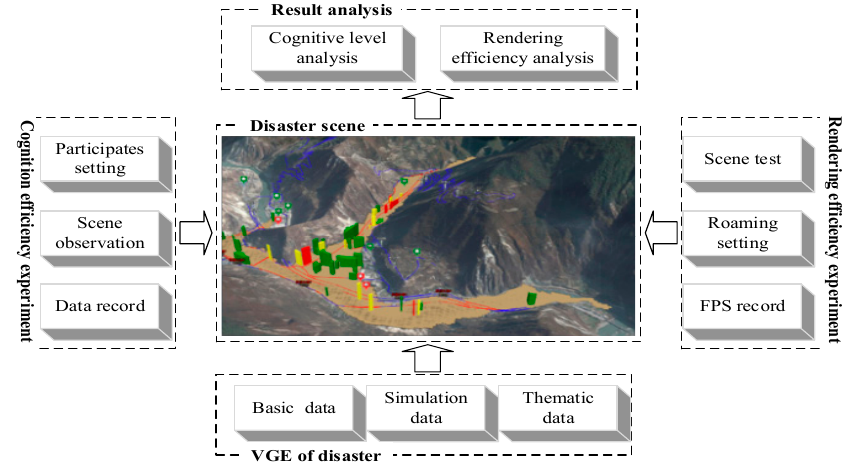
Figure 7. The design of the cognition and visualization efficiency of disaster scene experiments.